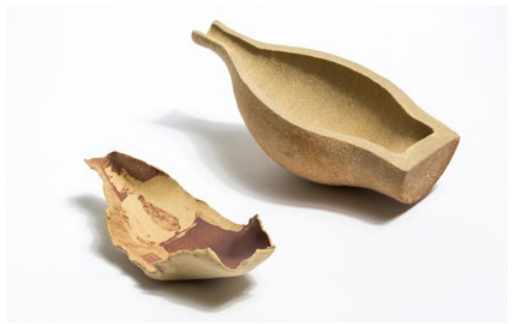
Figure 8.6 Inured. Oxide print on stoneware clay with hand-thrown dissected stoneware bottle (21 × 20 cm)